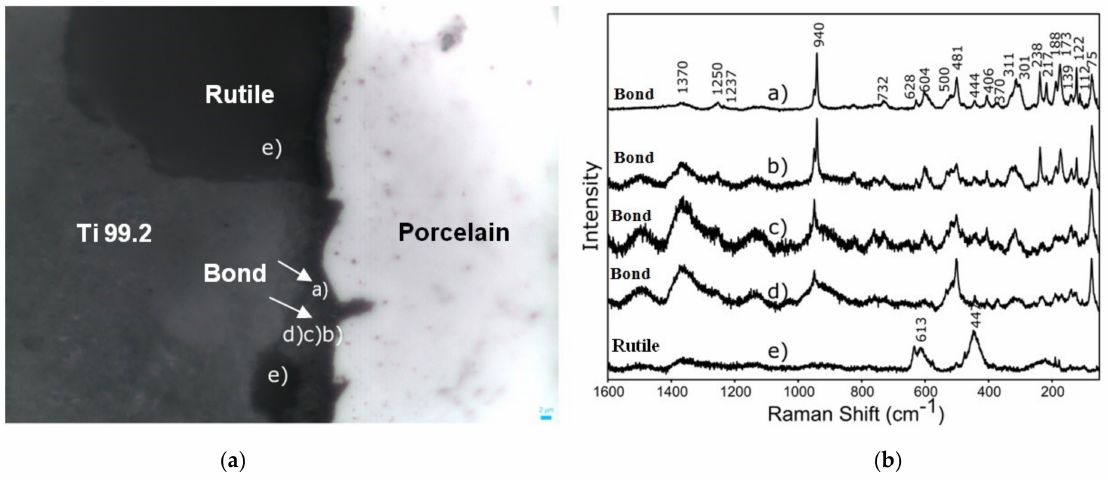
Figure 6. Raman spectroscopy measurements of titanium 99.2 − Duceratin Kiss dental